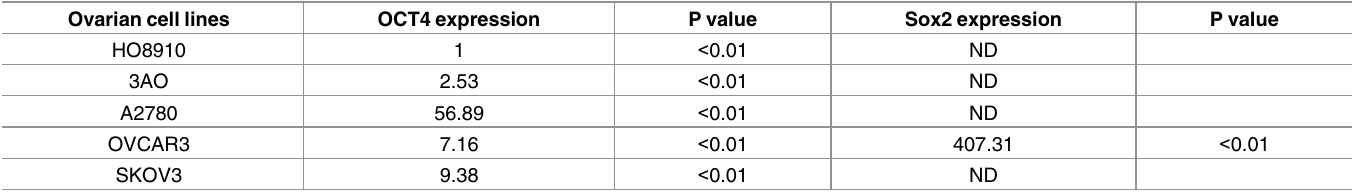
Table 5. OCT4 and Sox2 gene expression in ovarian cancer cell lines. Ovarian cell lines OCT4 expression P value Sox2